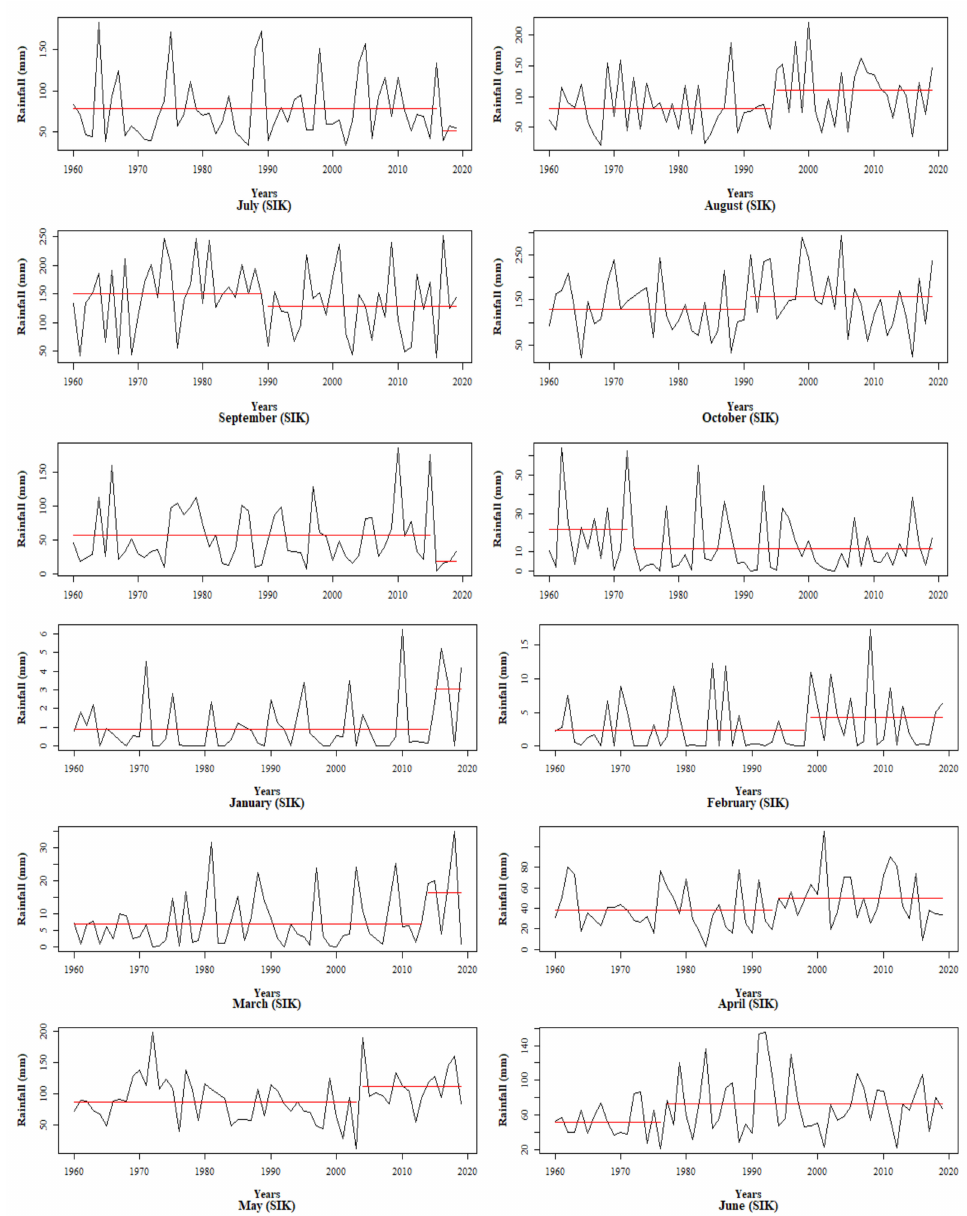
Figure 3. Monthly rainfall distribution along with shifting pattern in SIK over the years (the change in the continuity of horizontal red line indicates the year from which shift in rainfall pattern was observed. The next line starting from above the breakage point indicates a positive shift, i.e., increase in rainfall and vice